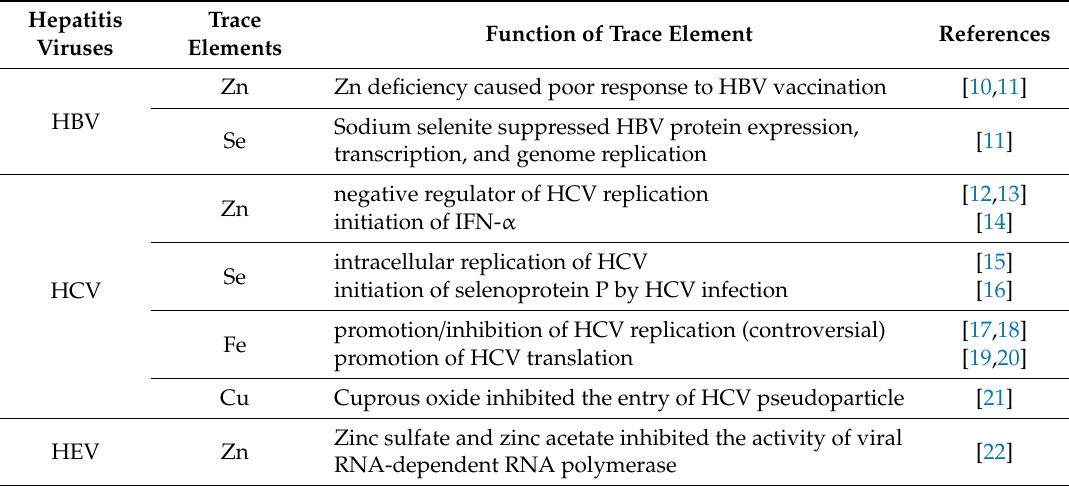
Table 1. Roles of trace elements in the translation, transcription, and replication of hepatitis viruses.